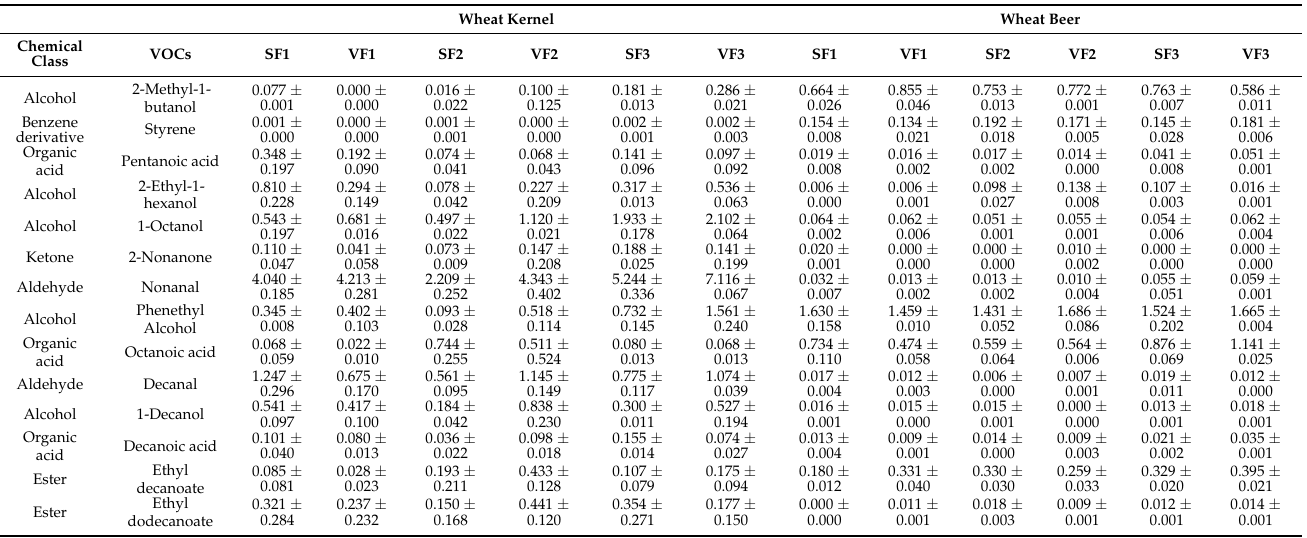
Table 1. Absolute peak areas, expressed as mean ± standard deviation, for common VOCs between wheat kernel and wheat beer